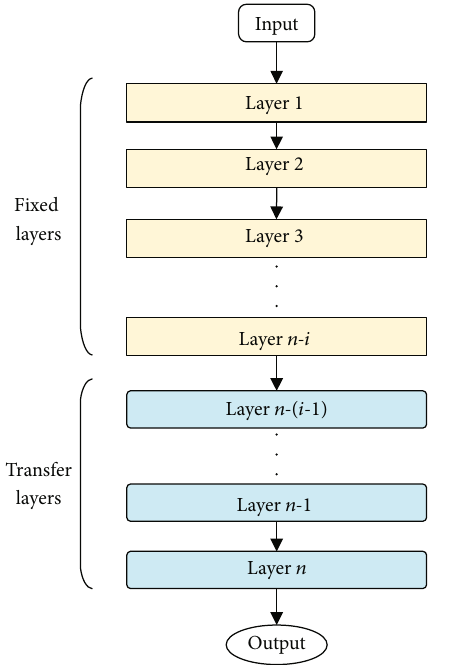
Figure 3: The structure of DTL.